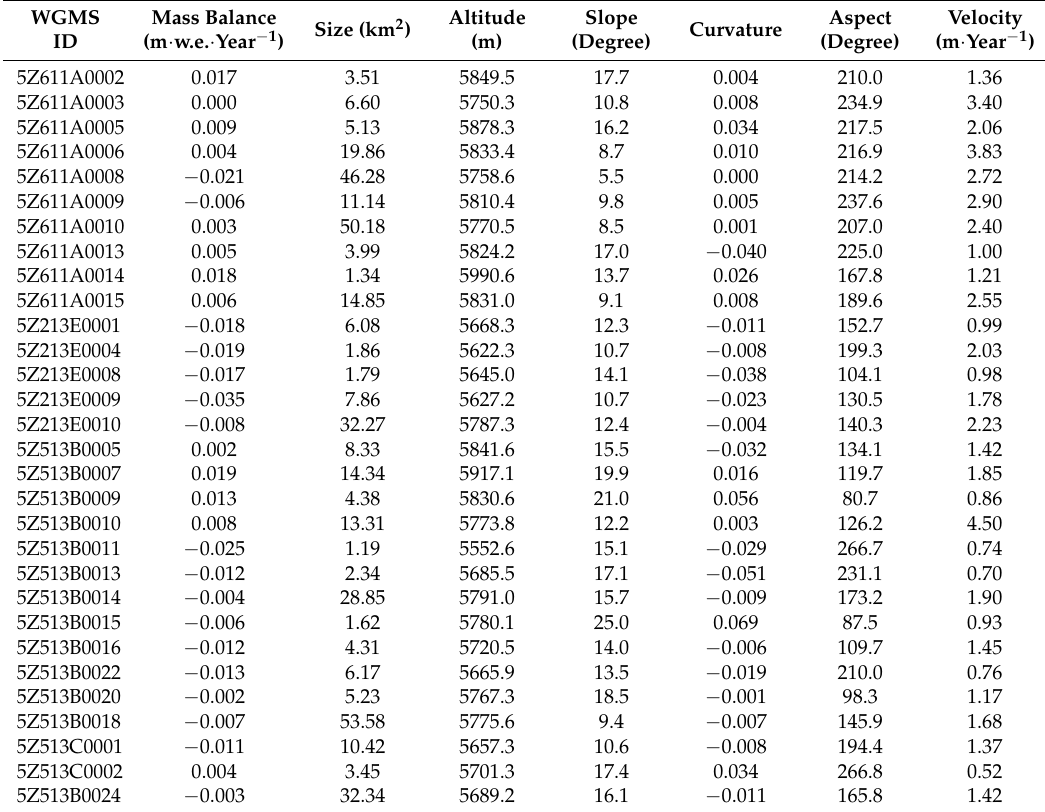
Table 1. Mass balances of glaciers with a size of greater than 1 km 2 on the PIF (except for the surge-type glacier) and glacier size and mean values of other morphometric factors.